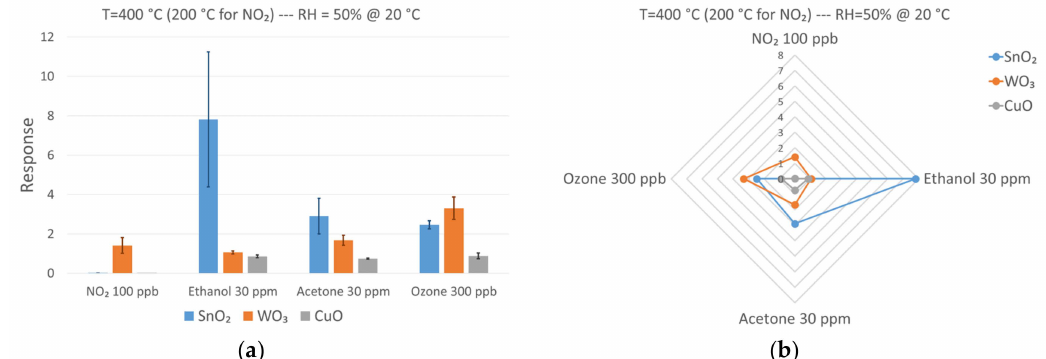
Figure 7. ( a ) Comparison of di ff erent sensing materials towards specific concentrations of target chemical compounds. ( b ) Polar graph of the response spectra of the devices. Operating temperature for all sensing devices was 400 ◦ C towards ethanol, acetone, and ozone, while it was 200 ◦ C for nitrogen dioxide. Relative humidity was 50% at 20 ◦